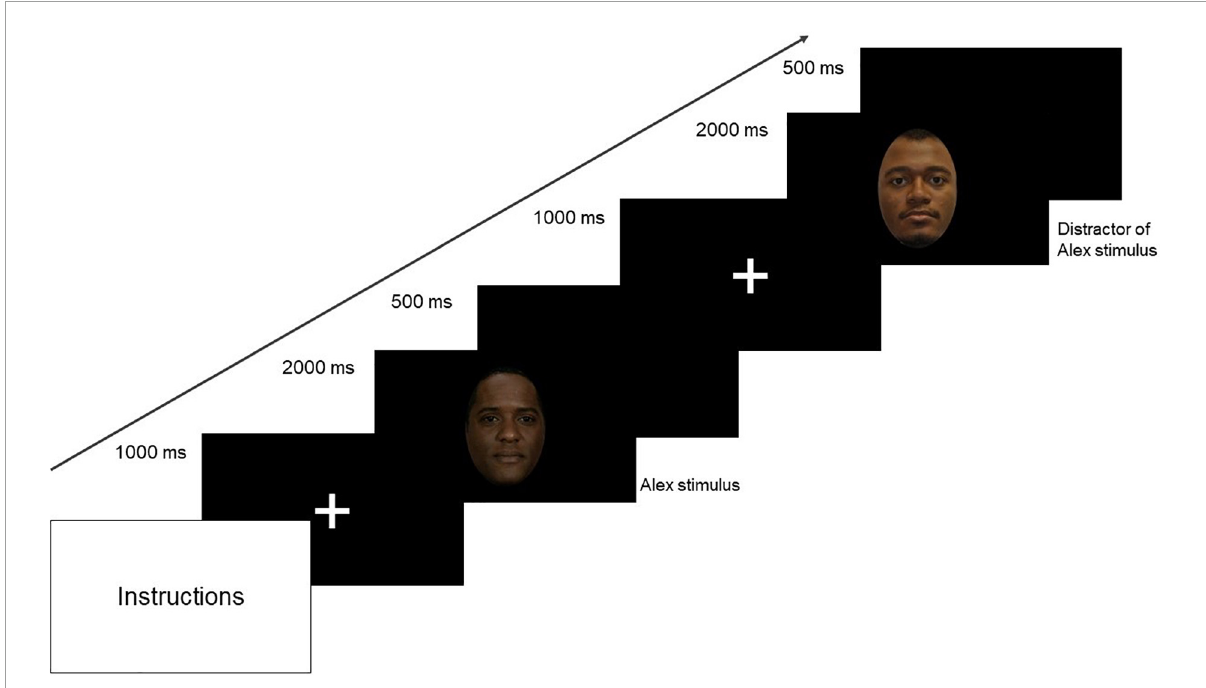
FIGURE3 Schematic representation of the hdEEG experimental